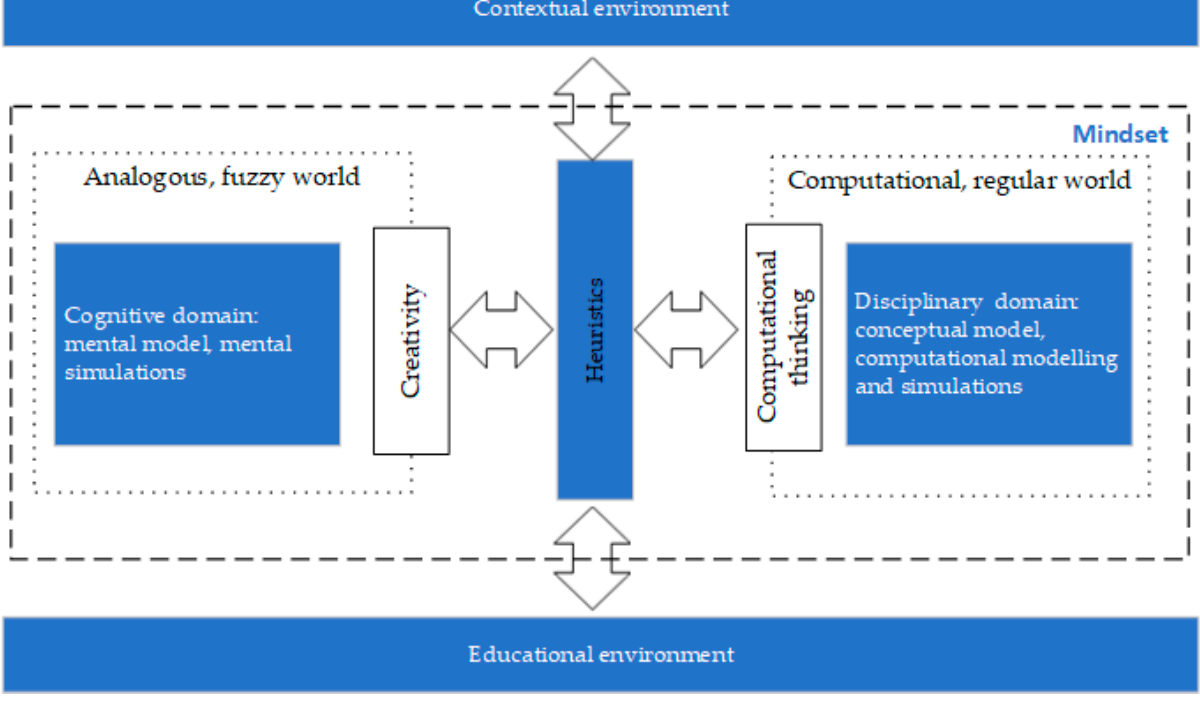
Figure 3. Empowering the learning landscape with CT (elaborated by the authors).